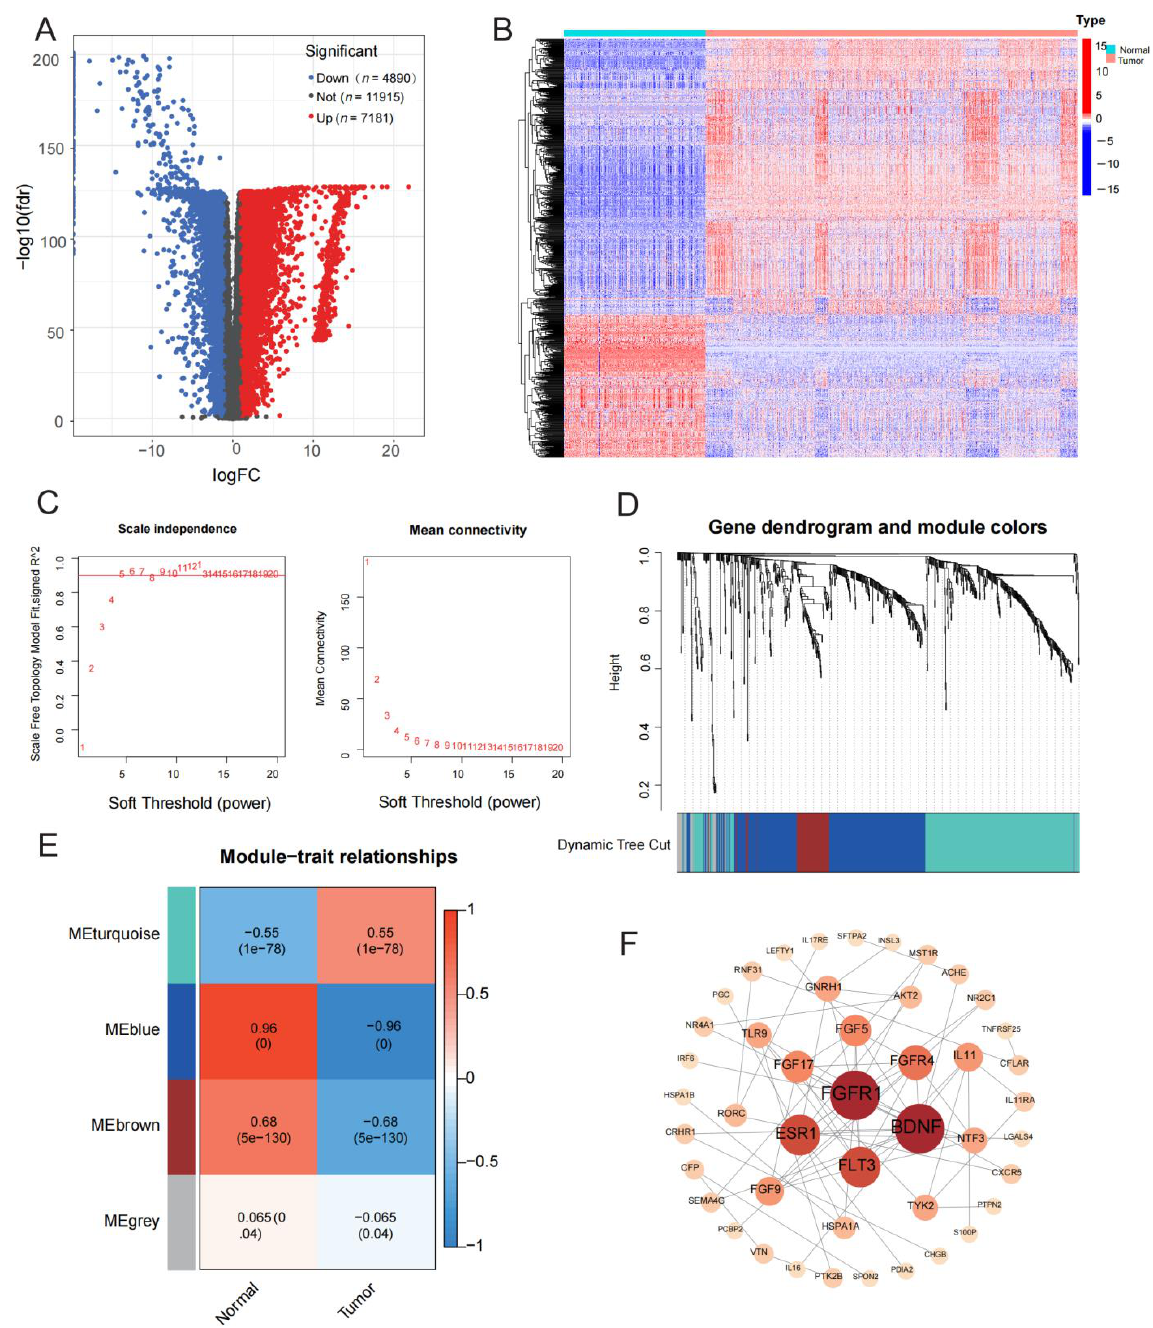
Figure 2. Screening of differentially expressed genes (DEGs) in glioma and identification of immune-related hub genes. ( A ) Volcanic map of DEGs between gliomas and normal samples. ( B ) Heatmap of the immune-related DEGs. ( C ) Determination of the optimal soft threshold. ( D ) Gene dendrogram and clustering modules. ( E ) Correlation and significance between modules and glioma. ( F ) Protein interaction (PPI) network diagram of significant modular genes.